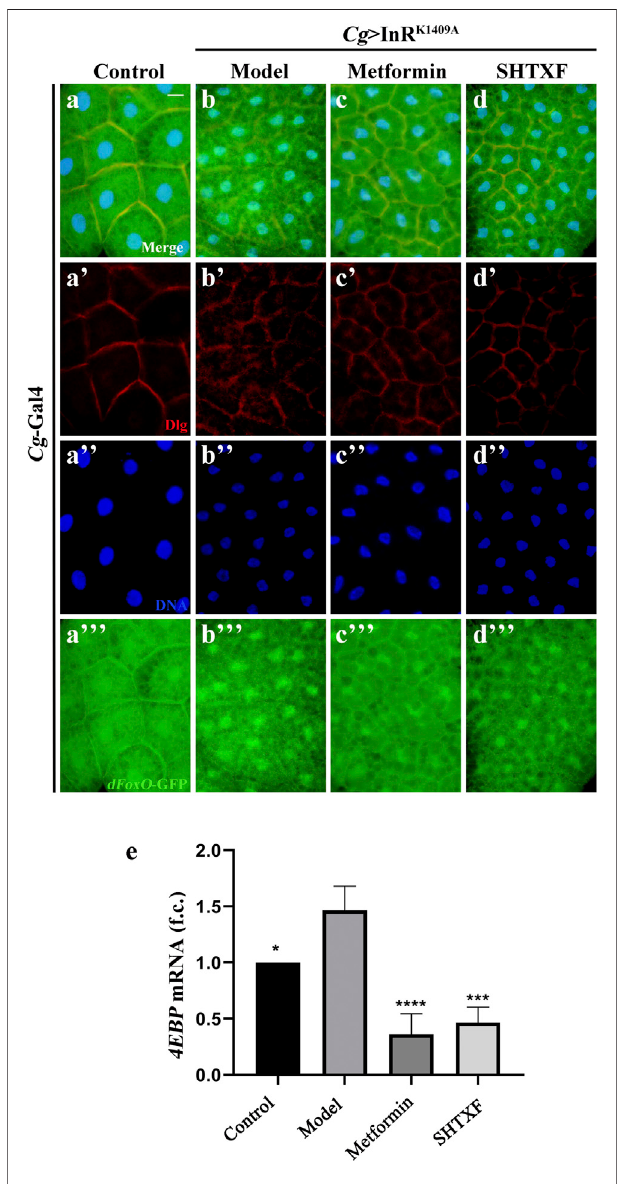
FIGURE 7 | SHTXF remedies Cg > InR K1409A -triggered dFoxO nuclear localization and transcriptional activity. (A – D) Representative merged fl uorescence micrographs showing the third-instar larval fat body carrying dFoxO -GFP reporter. The individual channels detect only Dlg [red, (A ’– D ’ )] , only DAPI [blue, (A ’’– D ’’ ) ], and only dFoxO -GFP [green, (A ”’– D ”’ ) ]. (E) Histogram shows the 4EBP mRNA transcription level as measured by qRT-PCR. Total RNA of Drosophila third-instar larvae was extracted and normalizedforcDNAsynthesis.Groups(fromlefttoright):control( Cg -Gal4/+), model( Cg -Gal4/+; UAS -InR K1409A /+),metformin( Cg -Gal4/+; UAS -InR K1409A / + fi les treated with 10 mM metformin), SHTXF ( Cg -Gal4/+; UAS -InR K1409A /+ fi les treated with 0.025 g/ml SHTXF) ( n = 3). The error bars indicate the standard deviation from three independent experiments. The p values were calculated by one-way ANOVA and Bonferroni ’ s multiple comparison test: **** p < 0.0001, *** p < 0.001 and * p < 0.05. Scale bar, 20 μ m (A – D) . Genotypes: (A) Cg -Gal4/+; dFoxO -GFP/+ and (B – D) Cg- Gal4/+; dFoxO - GFP/ UAS -InR K1409A .